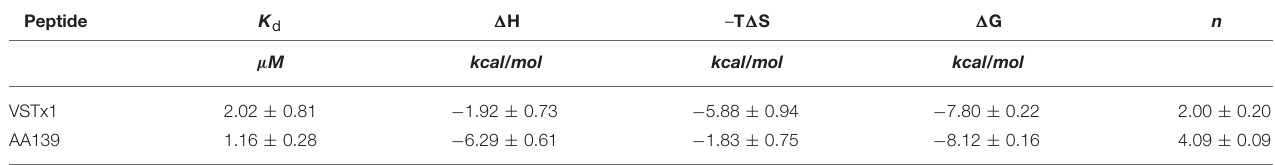
TABLE 2 | Thermodynamic parameters for VSTx1 and AA139 binding to cNDs. Peptide K